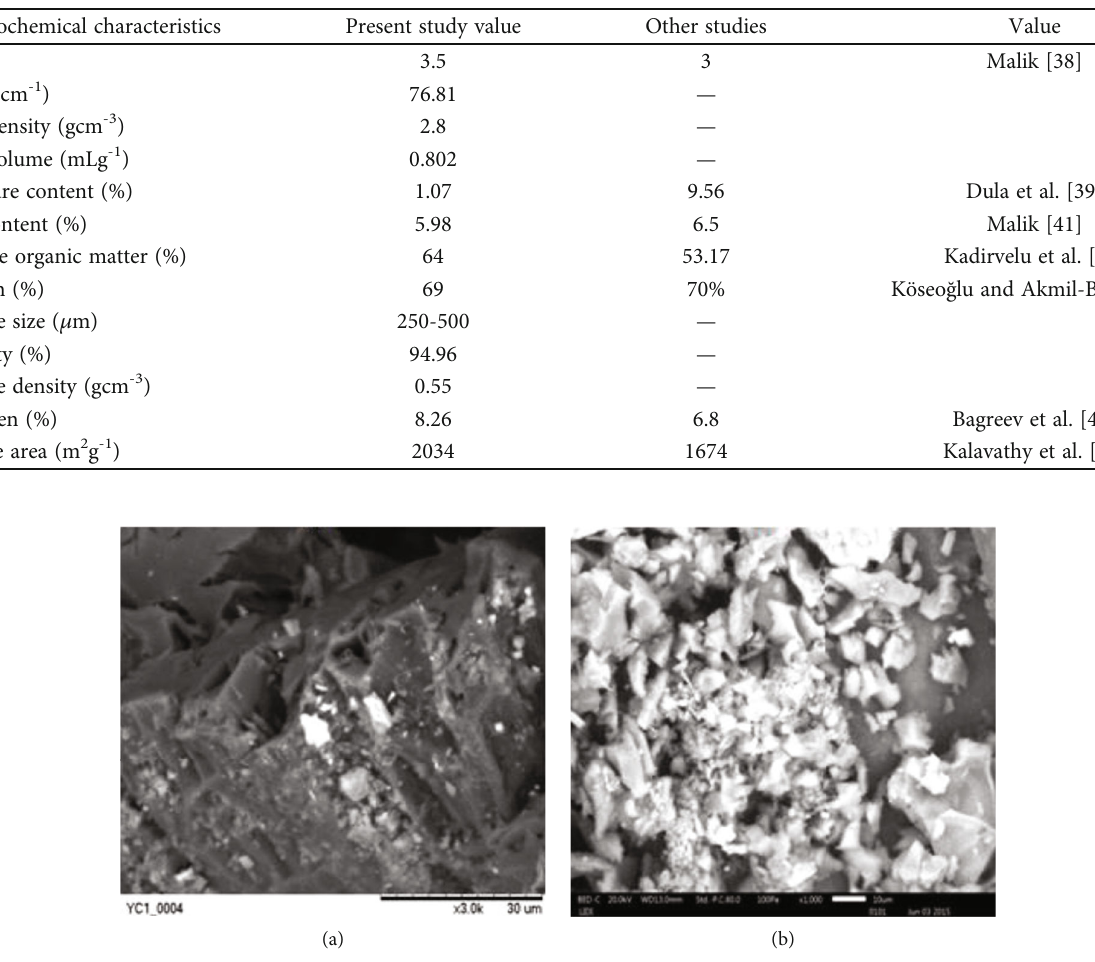
Figure 2: SEM micrograph of co ff ee husk activated carbon (a) after adsorption (b) before